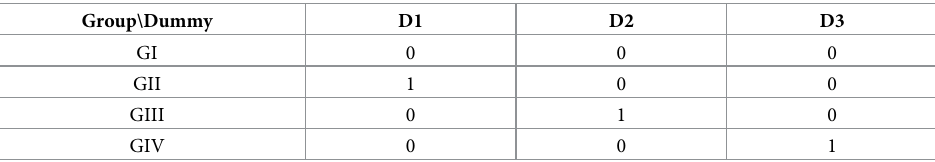
Table 1. Definition of dummy variables for age group from age as categorical